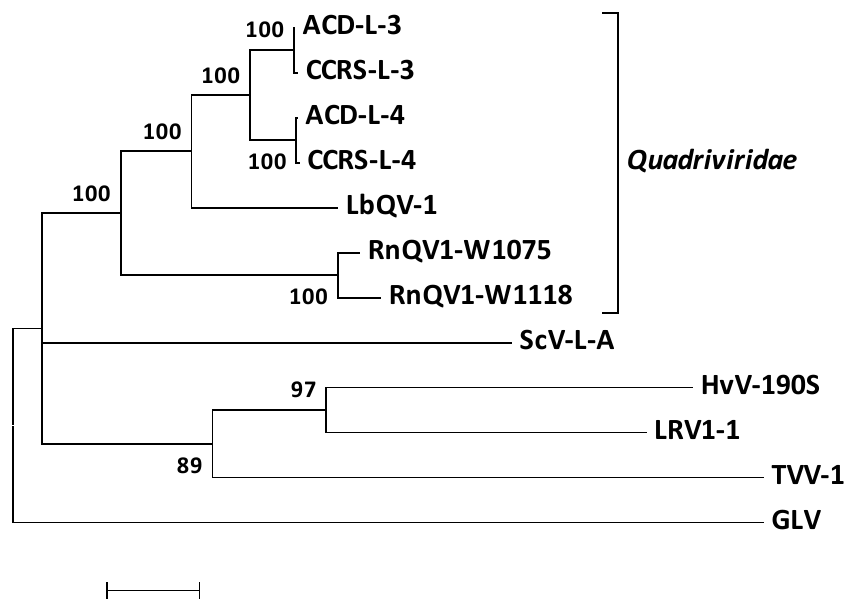
Figure 5. Phylogenetic analysis of Leptosphaeria biglobosa quadrivirus-1 (LbQV-1) RdRP and other known and suspected quadriviruses, together with selected members of the family Totiviridae based on the amino acid sequences of their RdRPs. The phylogenetic tree was constructed as described in the text. Only bootstrap percentages >50 are shown. Abbreviations and GenBank accession numbers for the sequences of the viral RdRPs used in the phylogenetic analysis are as follows: Amasya cherry disease-associated large dsRNA 3 (ACD-L-3; AM085134), Amasya cherry disease-associated large dsRNA 4 (ACD-L-4; AM085135), cherry chlorotic rusty spot-associated large dsRNA 3 (CCRS-L-3;